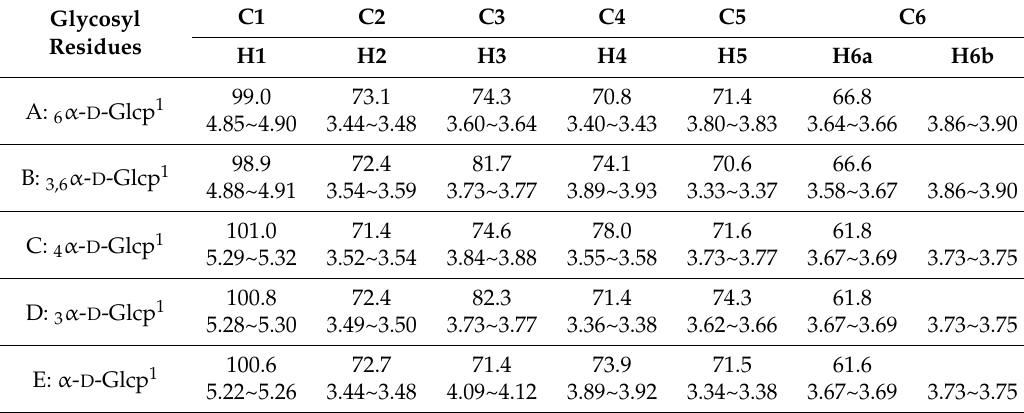
Table 2. Signal assignments of the 1 H- and 13 C-NMR spectra of BP1 based on the analysis of H-HCOSY, HSQC and HMBC spectra